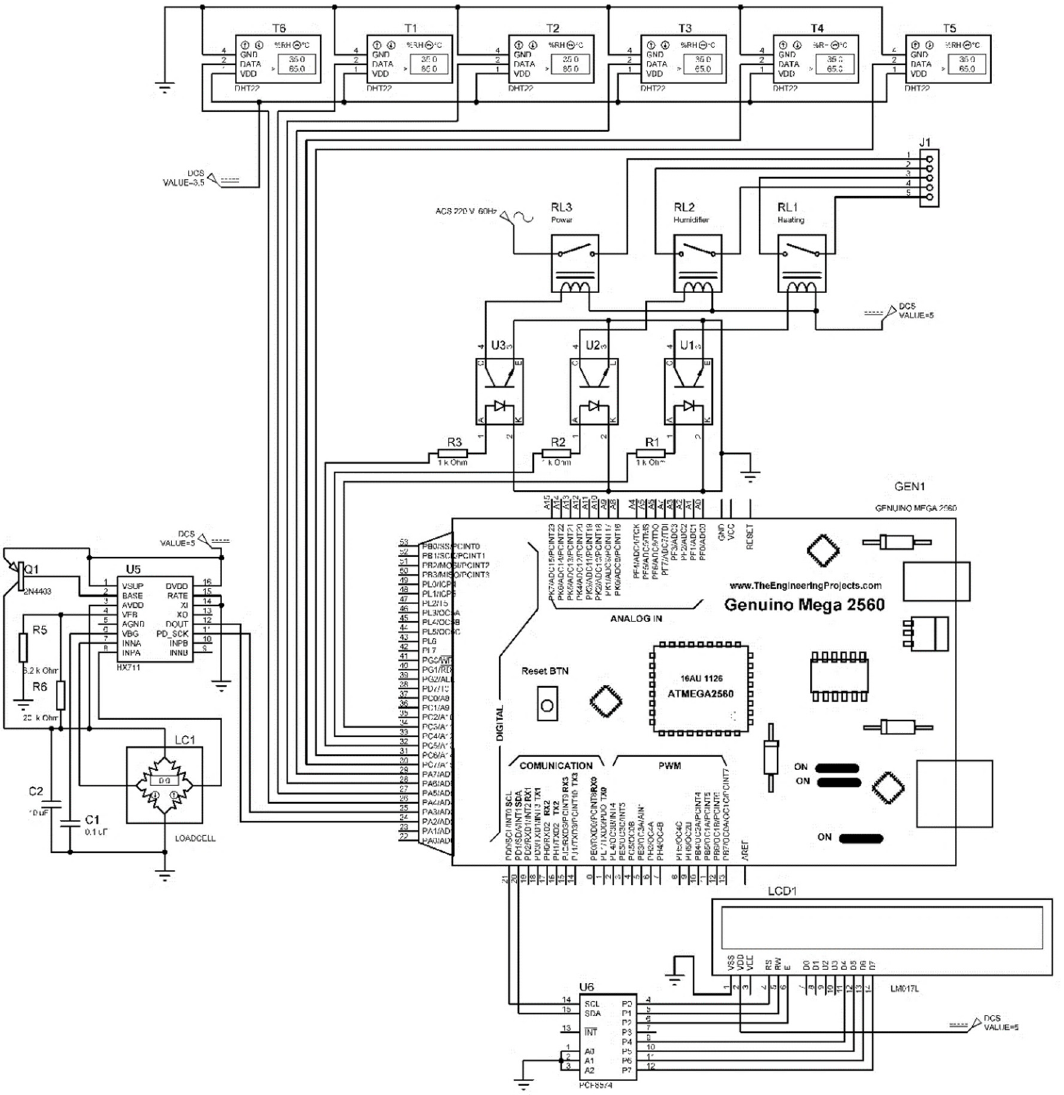
Figure 3. The schematic Proteus circuit diagram shows the major components of the sensor-based S-BARS control and monitoring. RL1, RL2, and RL3 are the relays for controlling the operation of the heating unit, the ultrasonic humidifier, and main power, U1, U2, and U3 are the optocouplers, R1, R2, R3, R4, R5, and R6 are the resistors, GEN1 is the Arduino Mega microcontroller with GENUINO MEGA 2560 Microchip, LC1 is the Load Cell sensor, U5 is the HX711 signal amplifier, LCD1 is the liquid crystal display, U6 is the PCF8574 8-bit input/output (I/O) expander, ACS is the 220 VAC power source, and DCS is the DC power source.